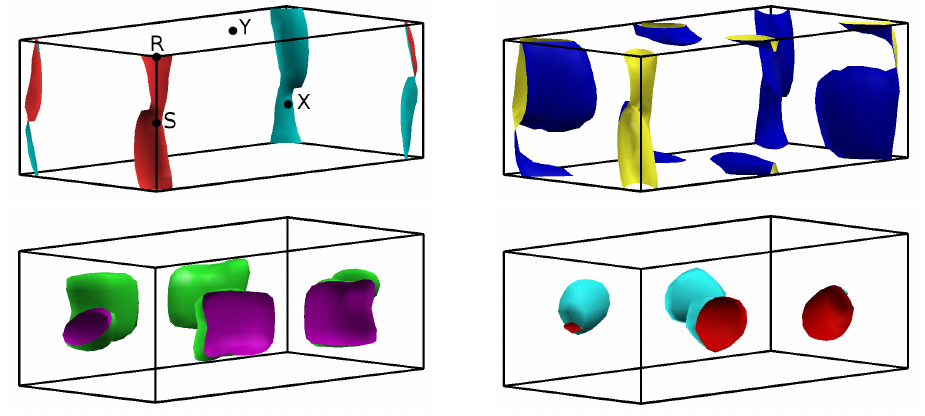
Figure 9: Left: Calculated Fermi sheets of LaNiO romagnetic P -type